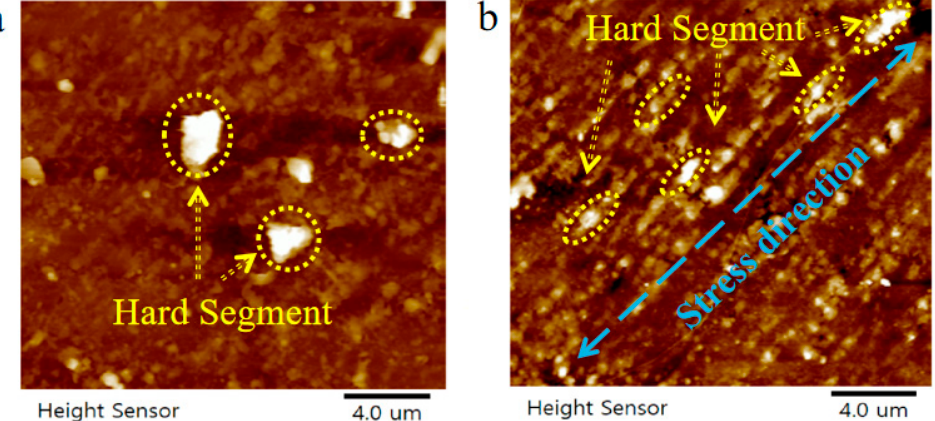
Figure 4. AFM image of the TPU sample after break. ( a ) Before loading. ( b ) After loading. The bright area is the hard segment.